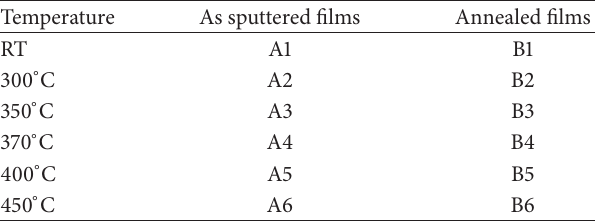
Table 3: Deposition condition of the CZTS absorber layer.